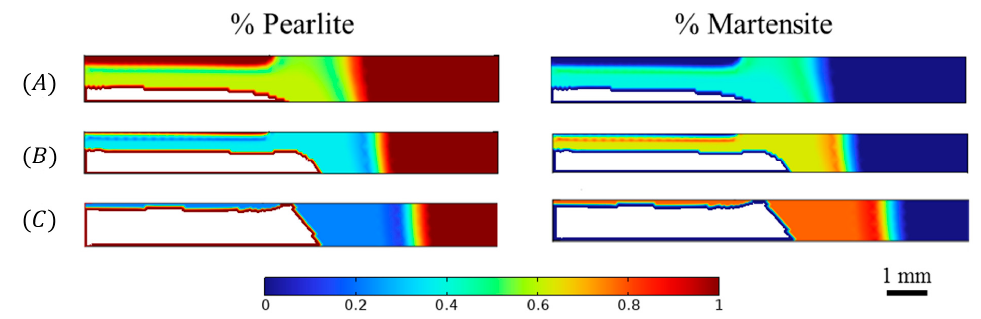
Figure 12. Simulation results of martensite distribution in HAZ region, ( a ) 1250 A and 0.5 s, ( b ) 2500 A and 1 s, ( c ) 3750 and 1.5 s.